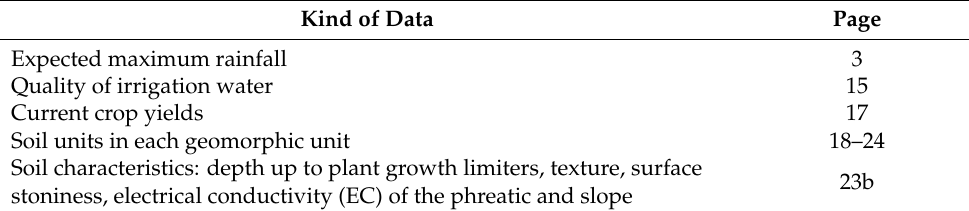
Table 2. Main data in the IRYDA report [1] with the page number where they